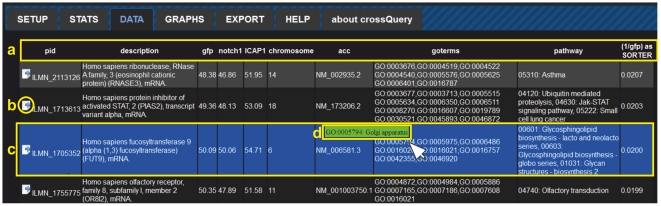
The Data tab of CrossQuery shows(a) all columns of the dataset and adds an extra column (last one) to represent the value determined by the SORTER term defined during query setup. (b) The export icon allows copying single data-rows to the export view. (c) The currently active row is always highlighted and clicking it will open the respective gene-sequence resource page (Ensembl or RefSeq). (d) The GO-term column supports displaying the text-representation of the GO-ID as a hover-effect.